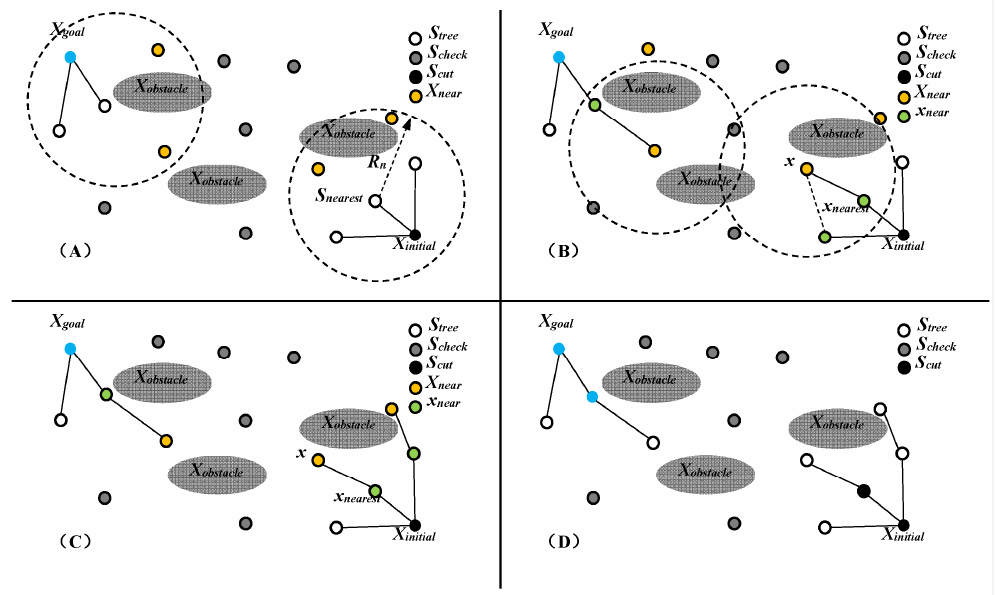
Figure 4. Schematic diagram of the iterative process of the Bi-FMT* algorithm. Sub-figure ( A ) shows the neighborhood point X near . Sub-figure ( B ) shows the connection of a new branch. Sub-figure ( C ) shows the all branches added based on X near . Sub-figure ( D ) shows the one step result of Bi-FMT*.